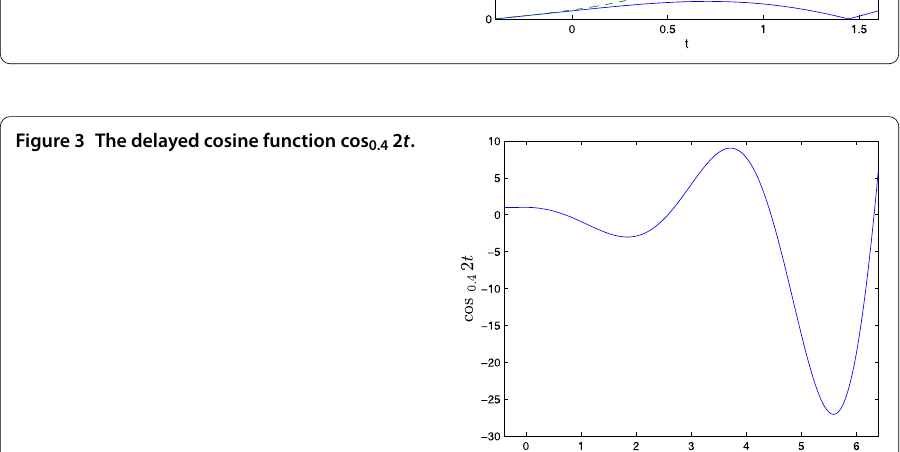
Figure 3 The delayed cosine function cos 0.4 2 t